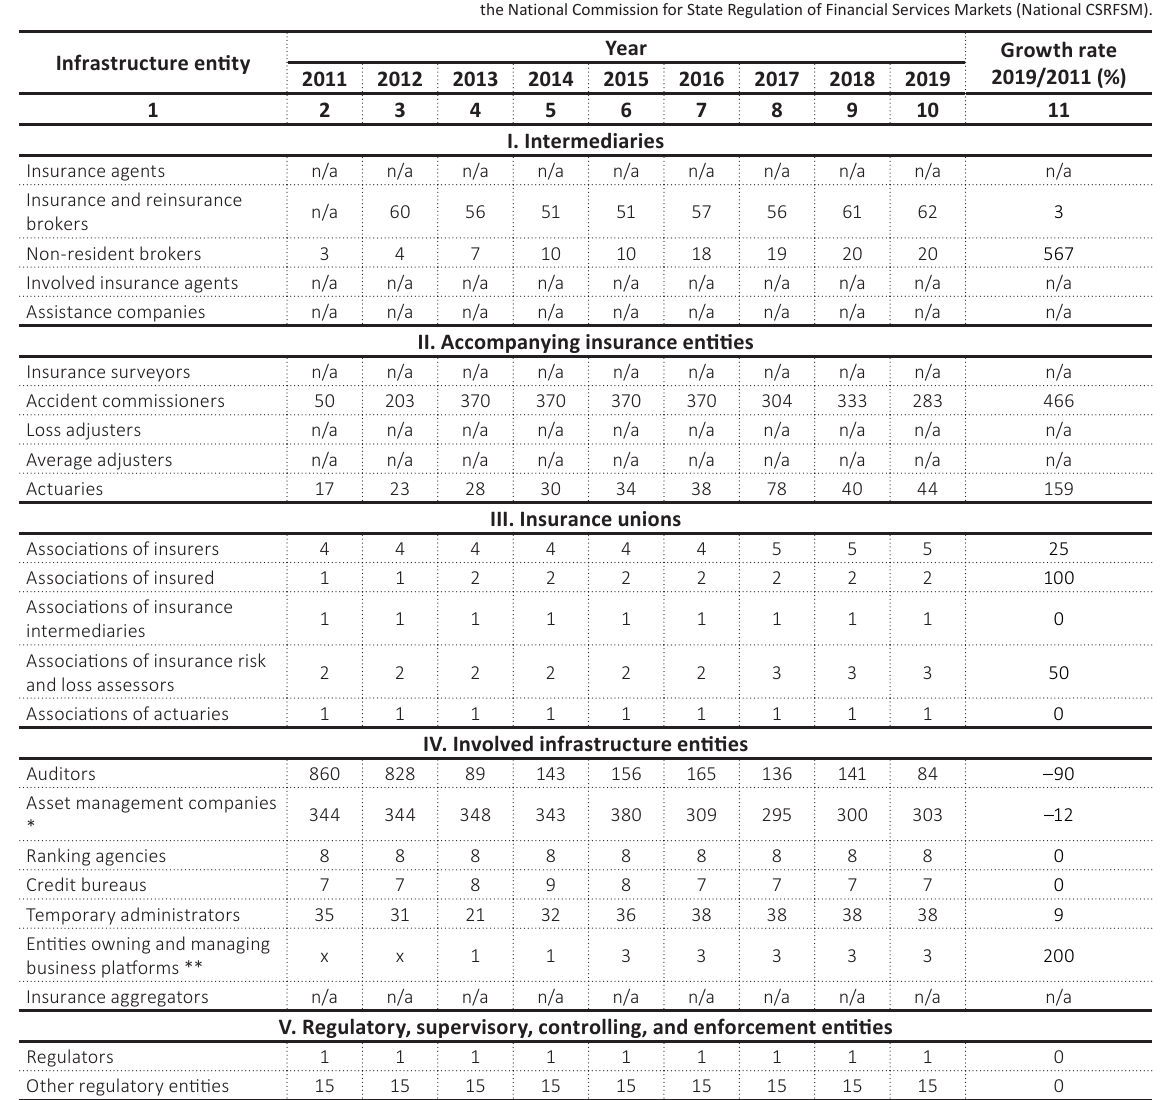
Table 2. Growth rates of insurance market infrastructure entities of Ukraine,